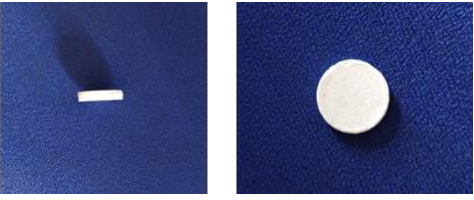
Figure 1. Synthesis of bioglass through sol gel route